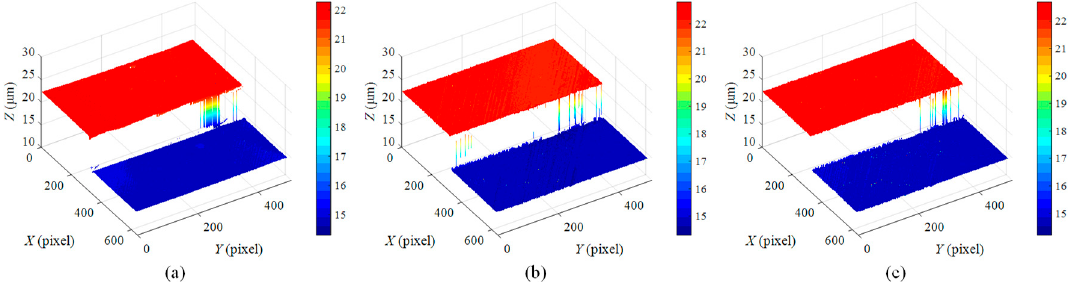
Figure 9. Surface profile of 7.347 µ m step height reconstructed by using: ( a ) centroid method, ( b ) FFT method, ( c ) HT method.